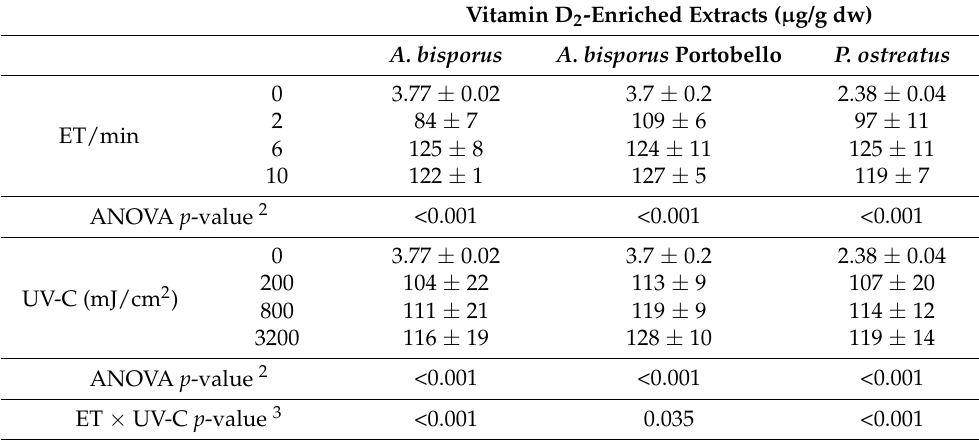
Table 2. Vitamin D 2 content in different mushroom species exposed to different UV-C radiation doses and exposure times (ET). The results are presented as mean ± SD 1 . Vitamin D 2 -Enriched Extracts ( µ g/g dw)